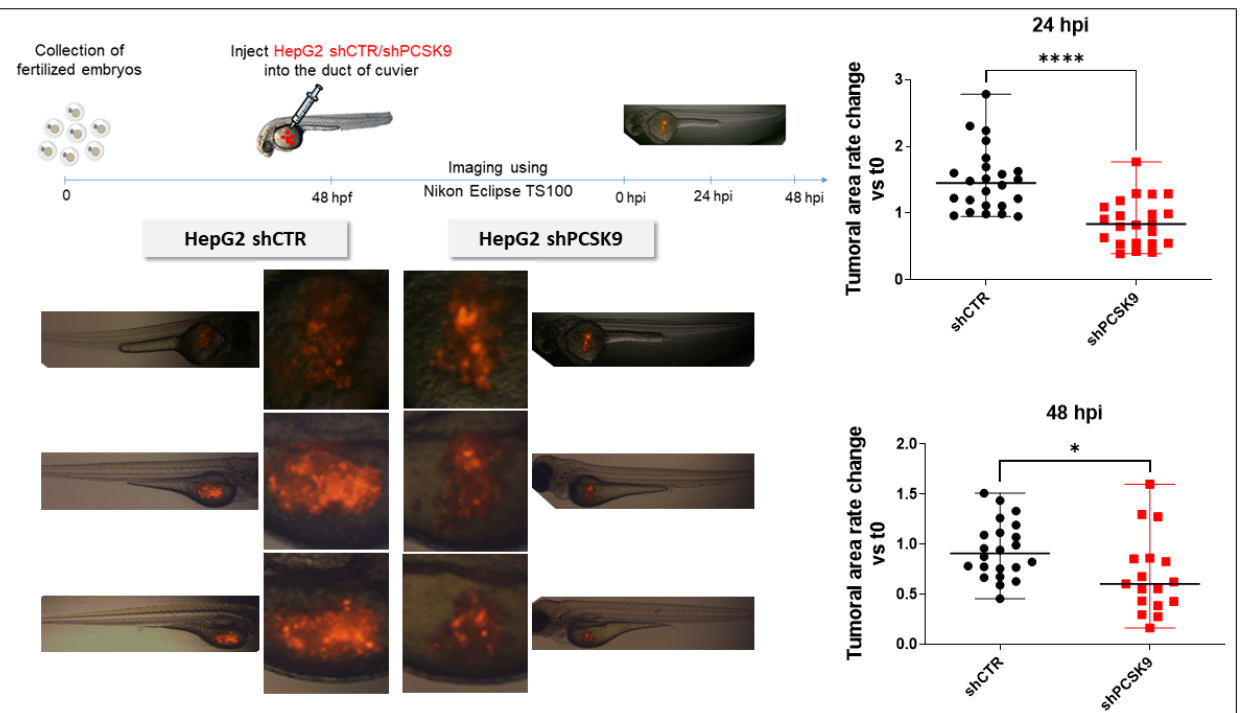
Figure 6. Depleting PCSK9 impairs liver tumor development in vivo. In zebrafish experiments: tomato red fluorescent labeled HepG2 with shPCSK9 or the control were xenografted in zebrafish embryos. Tumoral cell growth was evaluated by the quantification of the fluorescence 24 and 48 h post-injection (hpi). Unpaired t -test, *: p < 0.05, ****: p < 0.0001.